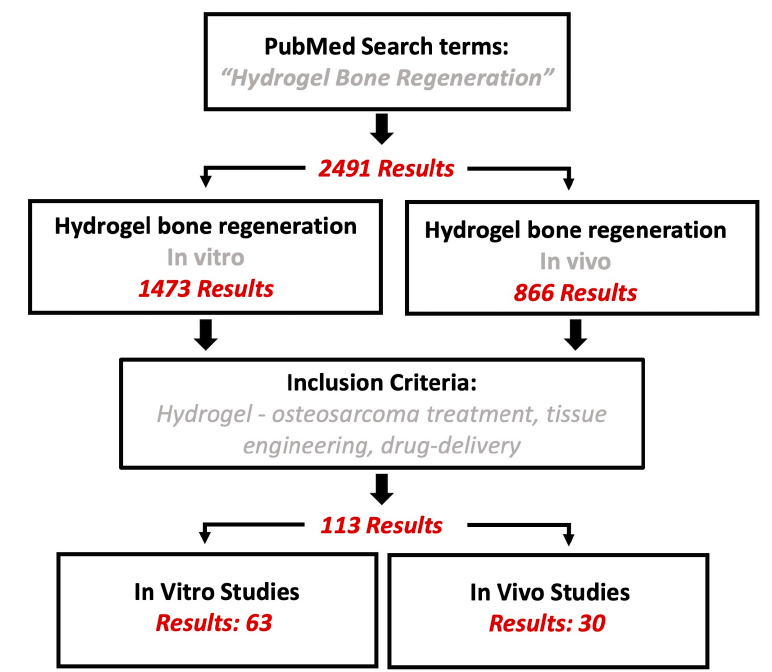
Figure 1. Flowchart of literature search using PubMed.